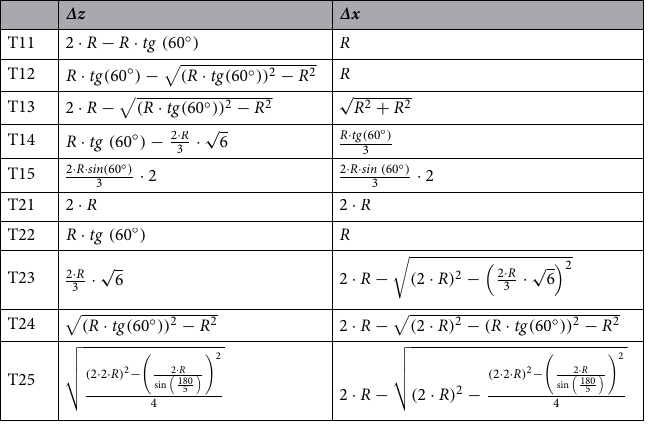
Table 1. Parameters Δz and Δx of individual displacements T 11 –T 15 and T 21 –T 25 .